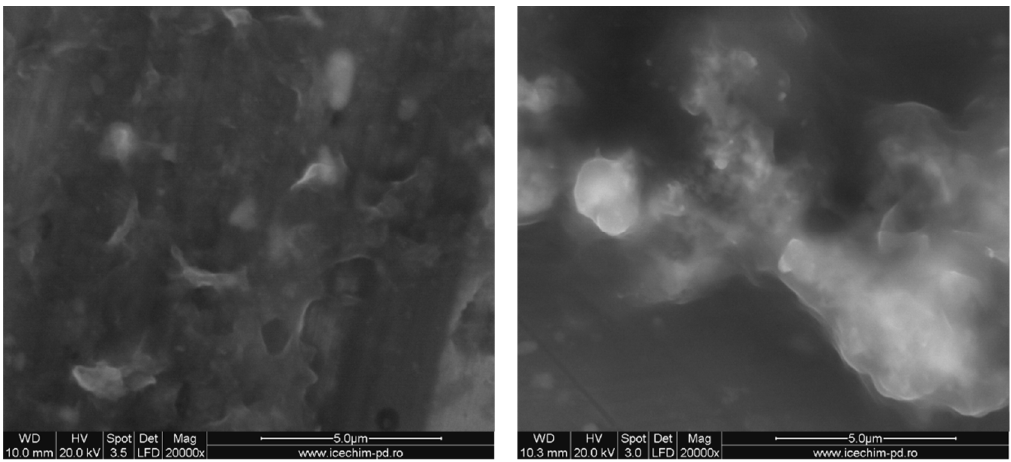
Figure 6. SEM pictures of ( I ) sample A (1/1 ODTMOS/SiO 2 ) and ( II ) sample H (0/1 ODTMOS/SiO 2 ) at 2/1 OLA/Na. at 2/1